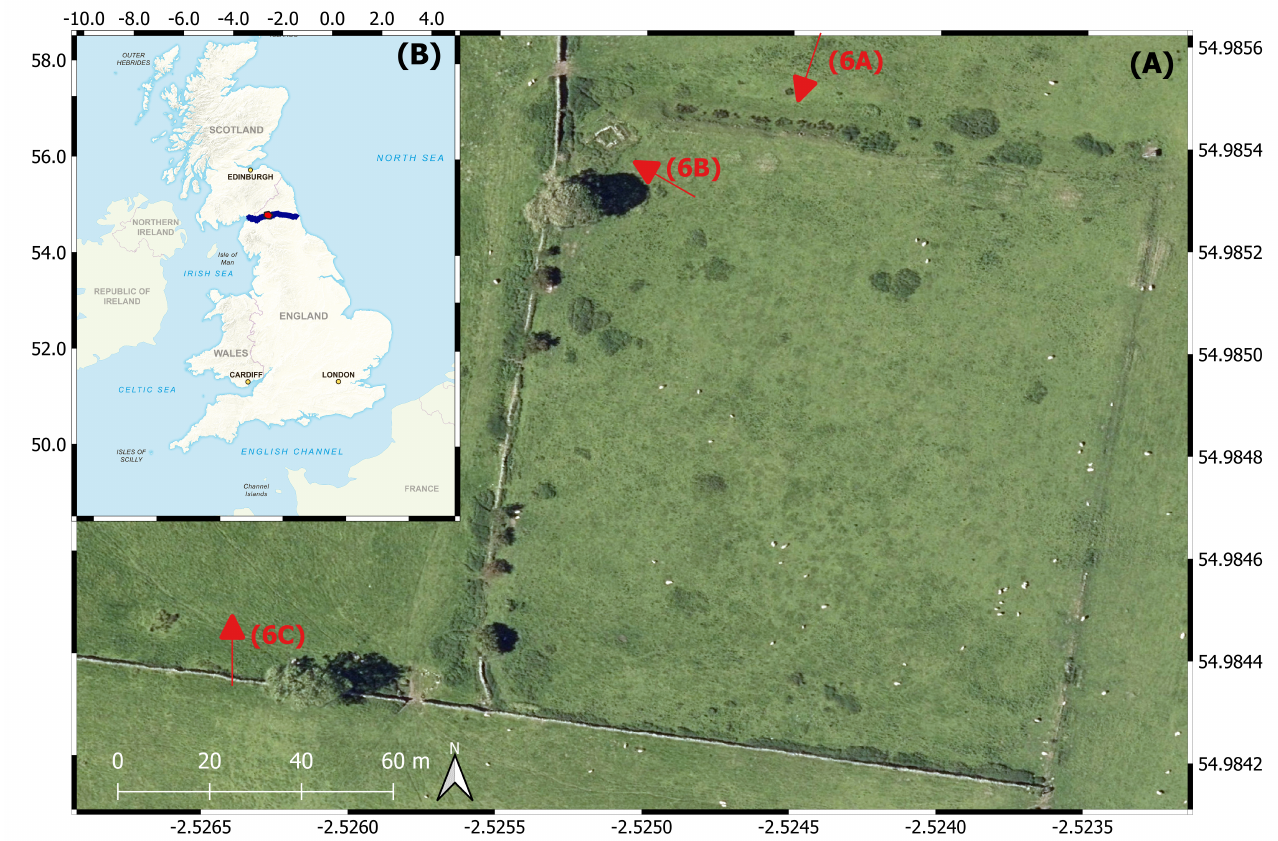
Figure 2. Annotated map of the Magna site displaying the condition of the site ( A ) in regard to soil and vegetation cover. The north-west section is the only part of the Fort clearly above ground. This is a 2018 drone image courtesy of the Vindolanda Trust. Inset Ordnance Survey “GB overview” map ( B ) shows the location of the fort in the UK (red) with the position of Hadrian’s Wall overlaid (blue). All coordinates are in WGS 84. The position and direction of photos from Figure 6 are displayed with the red arrows to further enhance visualization of the